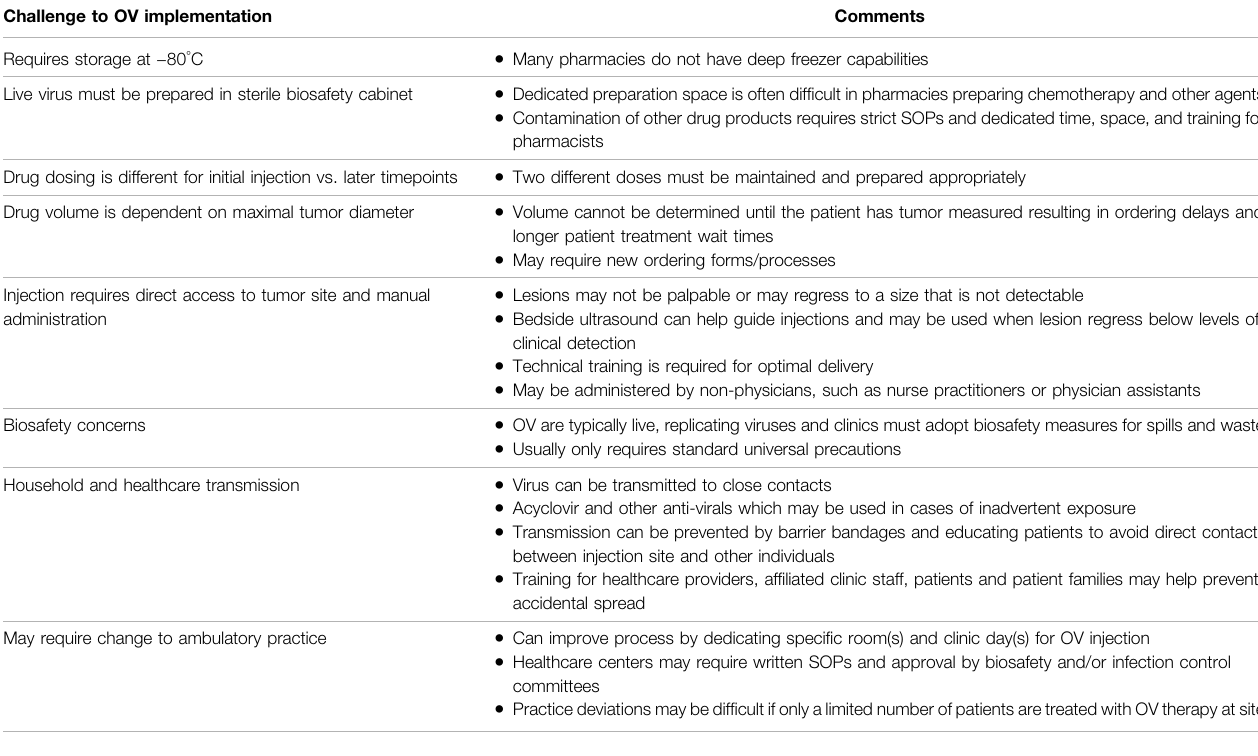
TABLE 1 | Barriers and challenges to oncolytic virus clinical implementation.